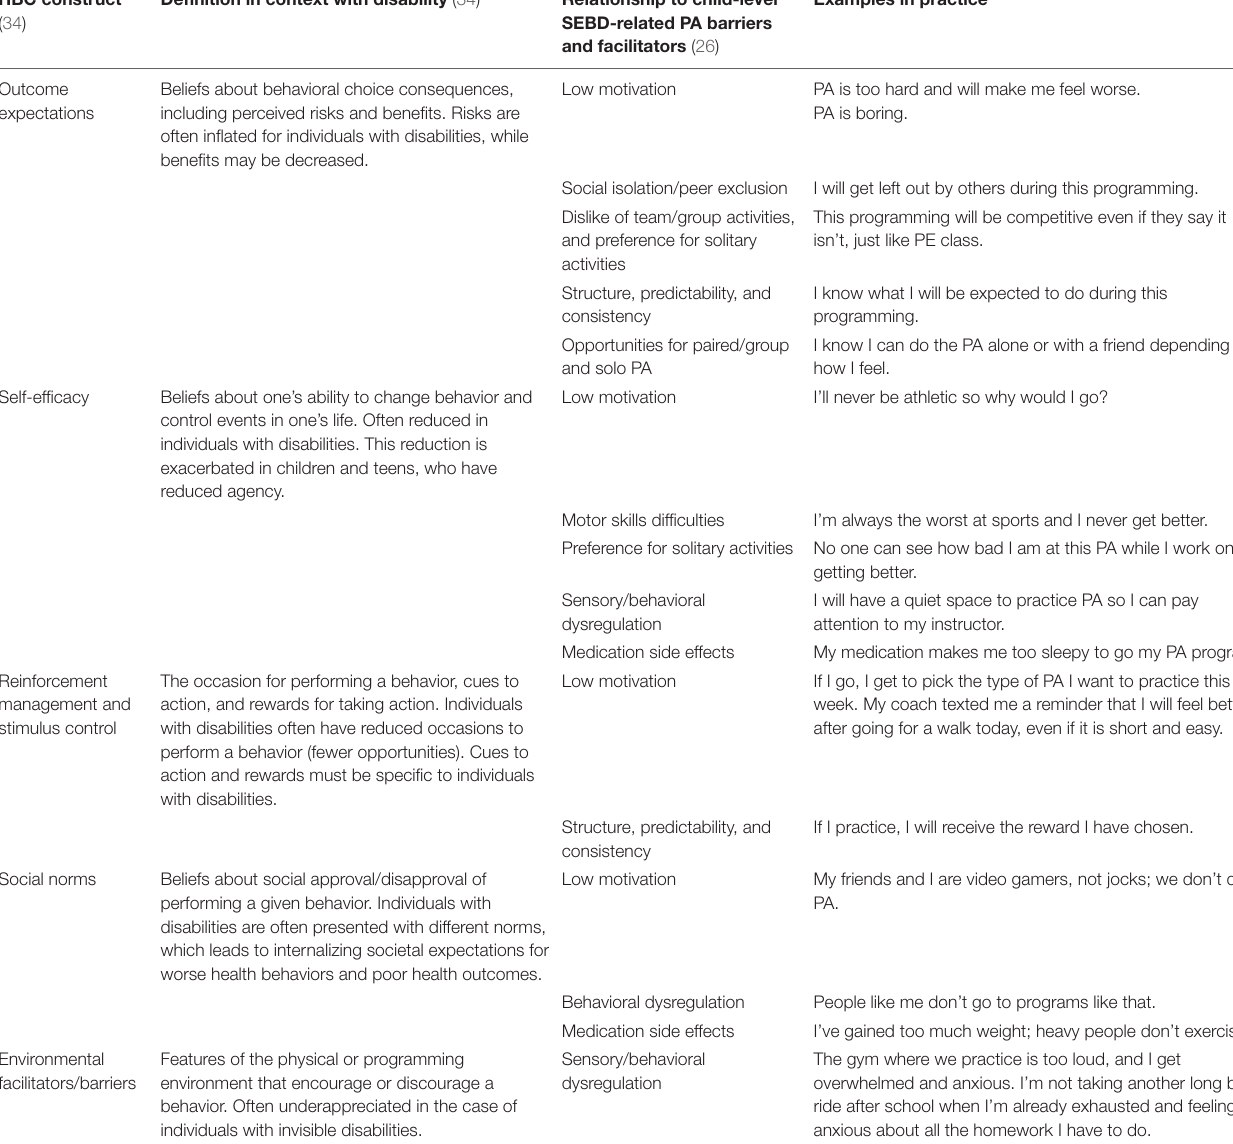
TABLE 2 | Cross-theoretical HBC constructs and application in SEBD-specific PA programming engagement. HBC construct